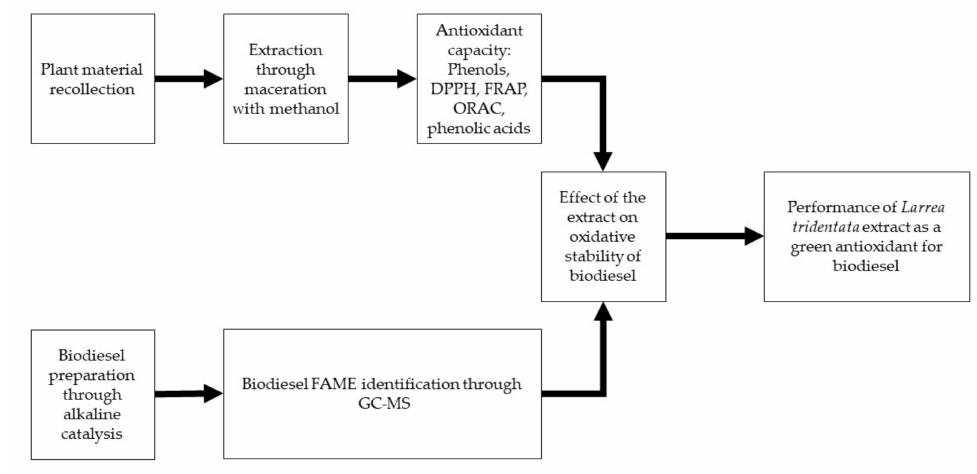
Figure 3. Flowchart of the methodology.